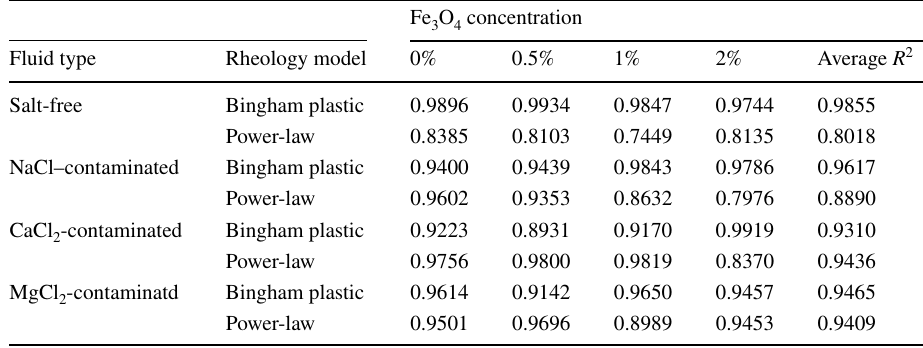
Fig. 2 Apparent viscosity of salt-free and salty drilling